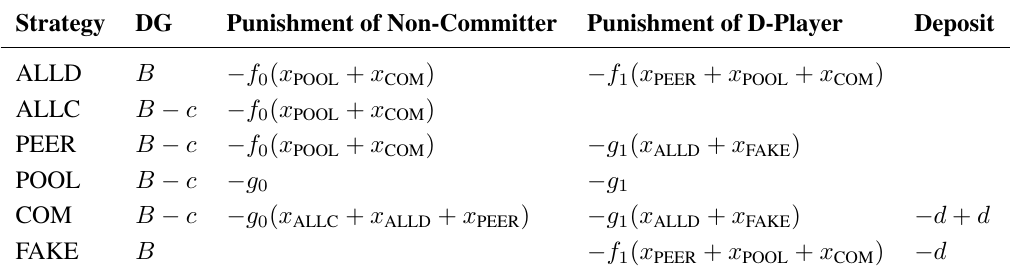
, f , g , g and d the coefficients 0 1 0 1 + x + x + x ) proportional to the fraction of ALLC PEER POOL COM ( x + x ) and f ( x + x + x ) are imposed, respectively, 0 1 POOL COM PEER POOL COM ( x + x ) for punishing 1 ALLD FAKE ( x + x + x ) for punishing 0 ALLC ALLD PEER